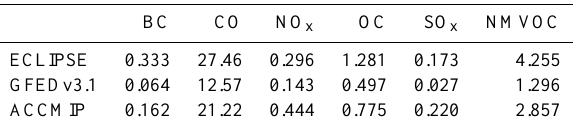
Table 3. Agricultural waste burning sector as provided for different emission inventories (in Tga − 1 ) for the year 2008. NO x is reported as